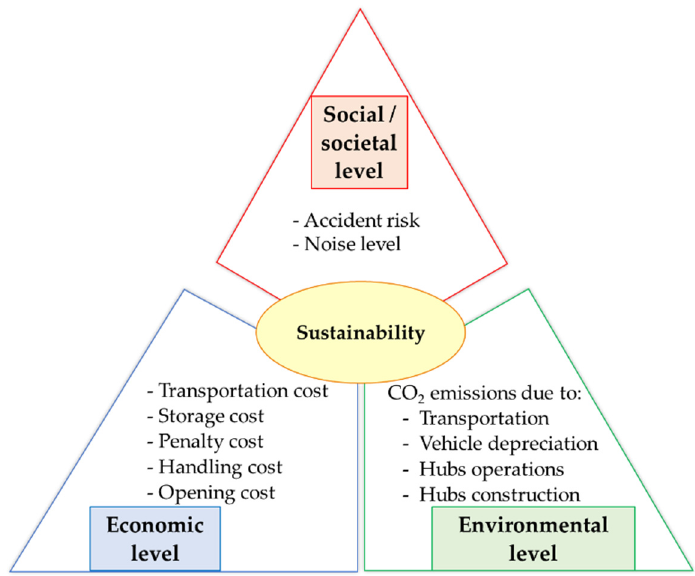
Figure 2. Evaluated sustainability